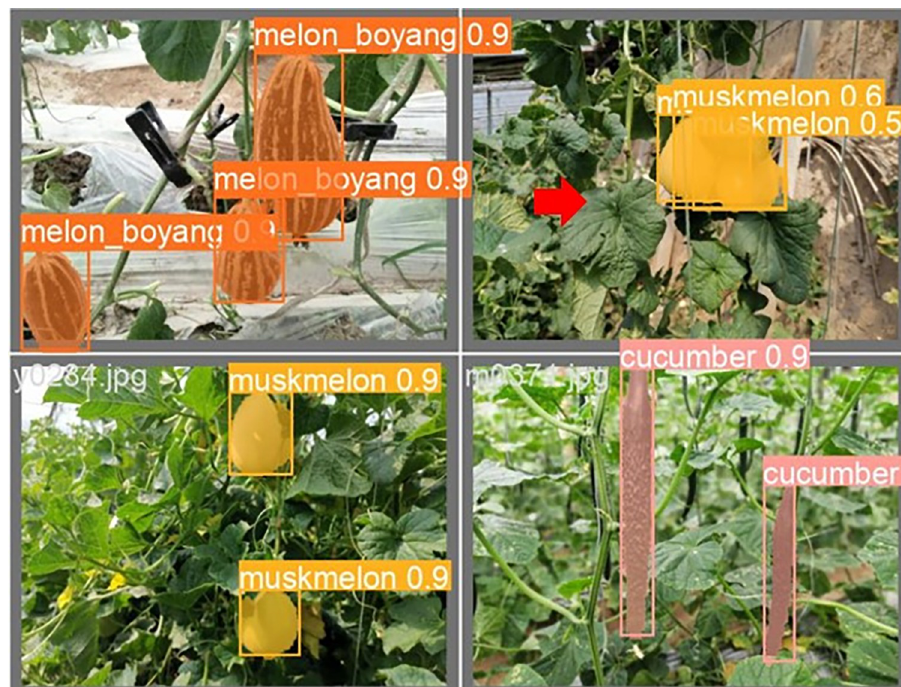
Fig 15. Image results of